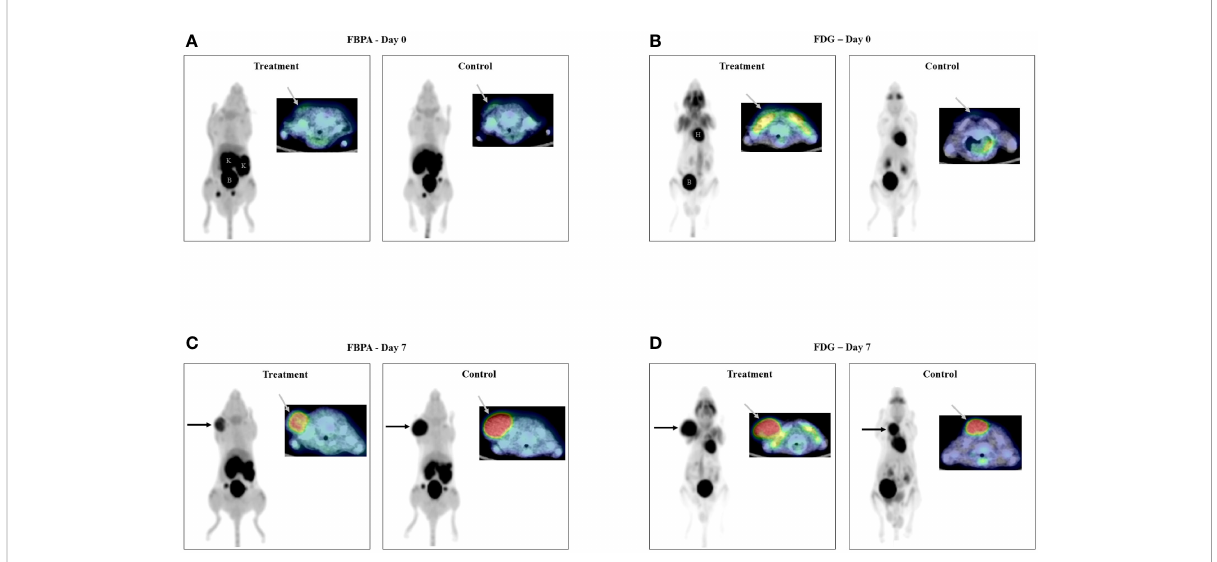
FIGURE 2 PET/CT images on Day 0 (2 A : FBPA, 2 B : FDG) Faint uptake (gray arrow) was observed in all tumors only on transaxial FBPA and FDG PET/CT images before treatment. PET/CT images on Day 7 (2 C : FBPA, 2 D : FDG) Intense uptake (black and gray arrows) was observed in all tumors on FBPA and FDG PET/CT images. Visual analysis did not discriminate the tumors in the treatment and control groups either on FBPA or FDG PET/ CT images. Radioactivities were observed in the kidneys (K) and bladder (B) and in the heart (H) and bladder (B) in addition to the tumor, respectively, as shown in FBPA and FDG PET images on Day 0. (Left: maximum intensity projection image of PET, right upper: fused PET/CT image, Treatment: PET image in the treatment group, Control: PET image in the control